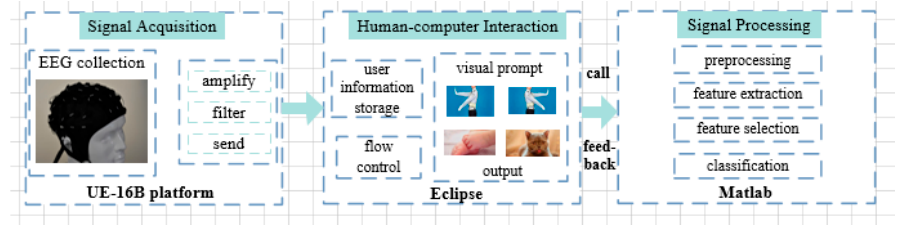
Figure 4. Structure of the real-time BCI system.